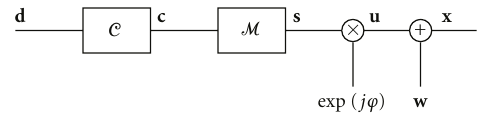
Figure 1: Signal space models.